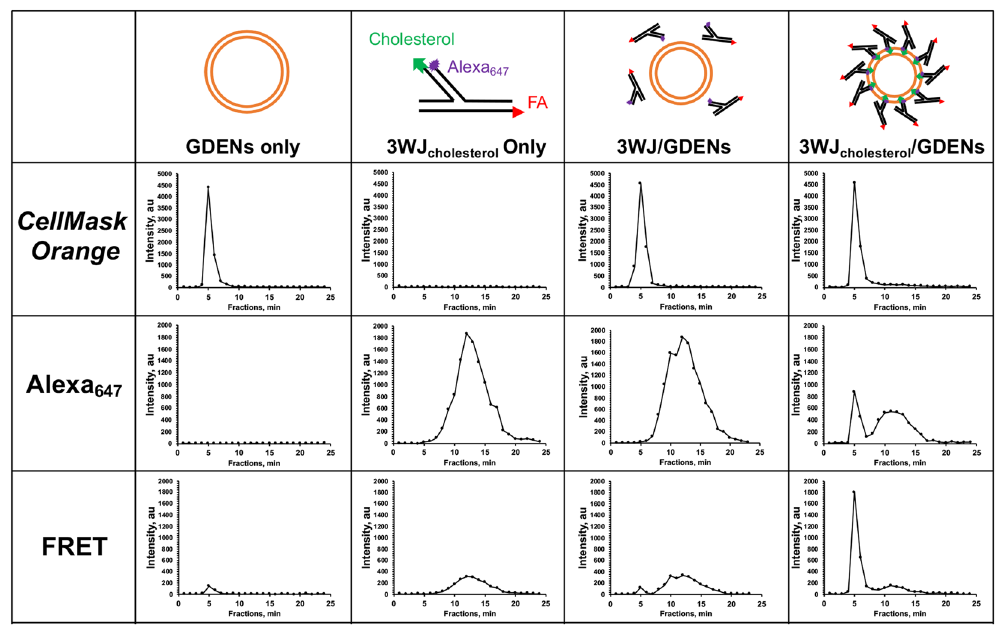
Figure 4. Histogram plotted by fluorescent intensity readout from individual fractions collected from Sephadex G-200 SEC after introduce sample by Cellmask Orange, Alexa 647 and Cellmask Orange-Alexa 647 FRET excitation/emission